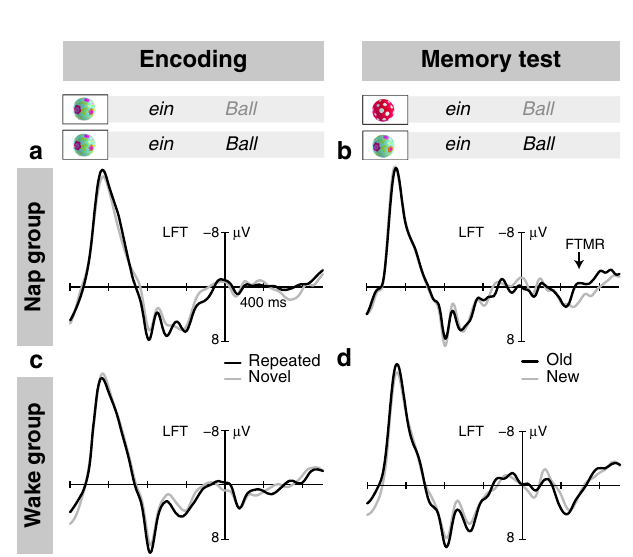
Fig. 3 Immediate and later memory for the episodic pairings of objects and words. a ERP responses of the nap group at encoding. Non-signi fi cant difference between the ERPs to words presented the second time in the same semantically correct object context (black lines) and the same words presented the fi rst time in this speci fi c object context (grey lines). b ERP